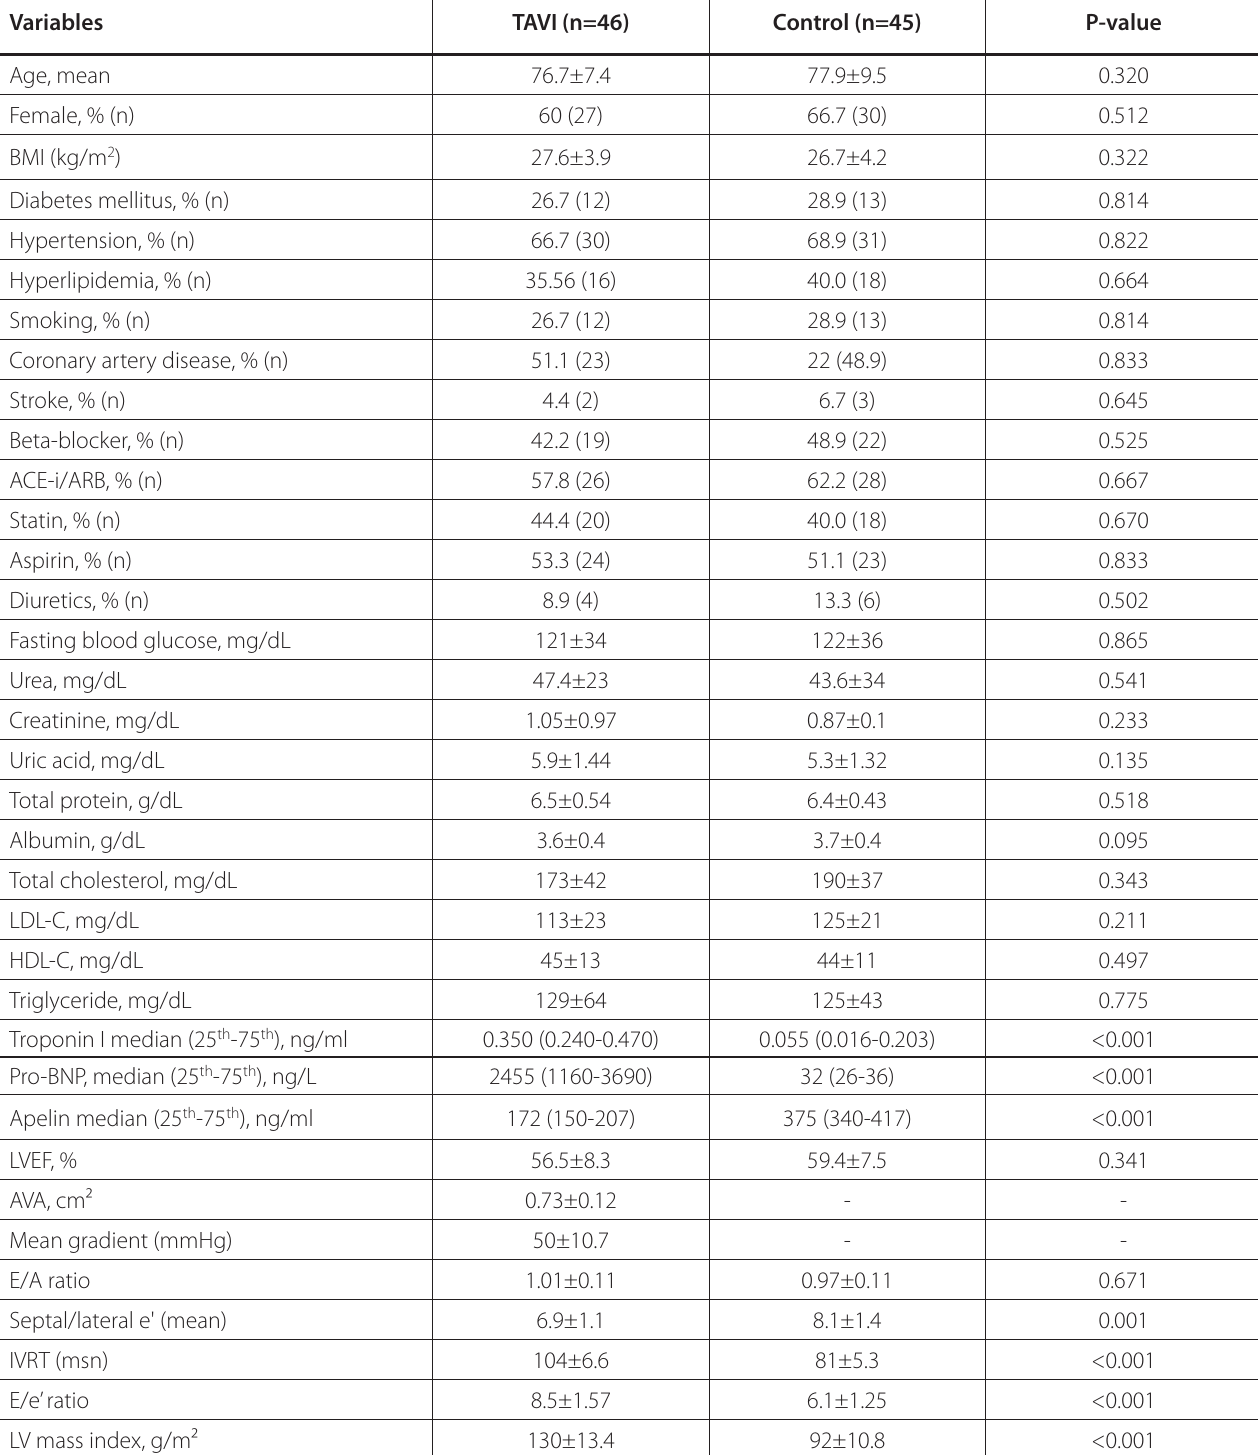
Table 1 . Comparison between the demographic and medical characteristics and echocardiographic parameters of the groups.